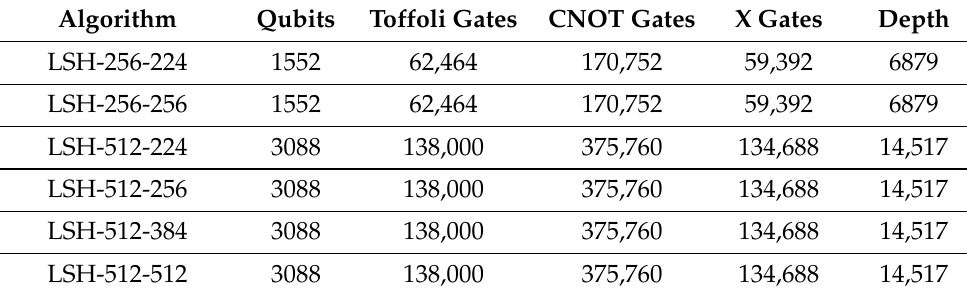
Table 6. Quantum resource estimation results for our LSH parallel quantum